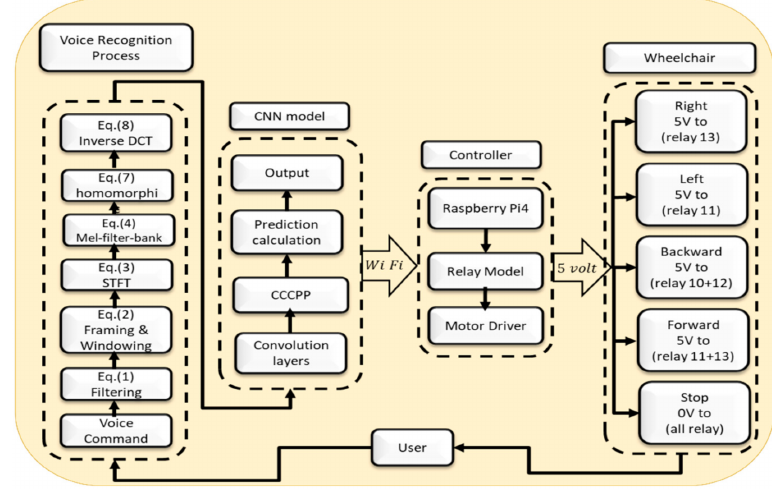
Figure 4. Flowchart of complete system for wheelchair